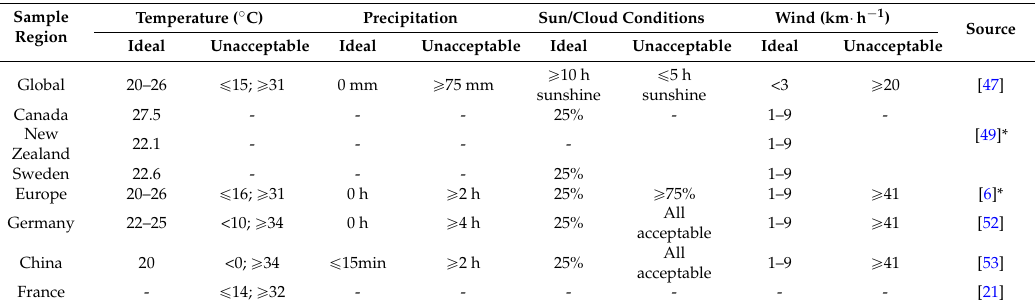
Table 1. Literature used to inform the design of the Holiday Climate Index (HCI). Sample